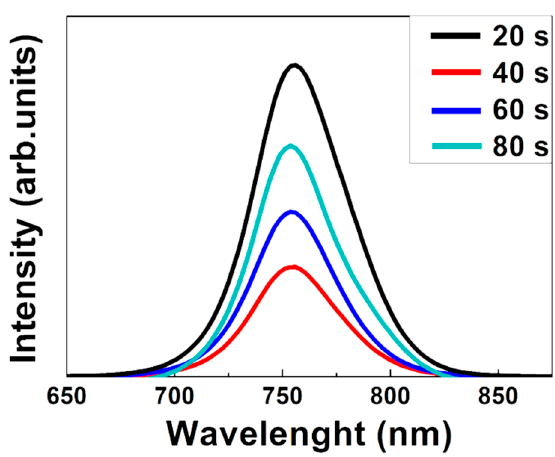
Figure 6. PL spectrum for CH 3 NH 3 PbI 3 perovskite film onto FTO/NiO x hole transport layers treated at various deposition times: 20 s, 40 s, 60 s, and 80 s, respectively.